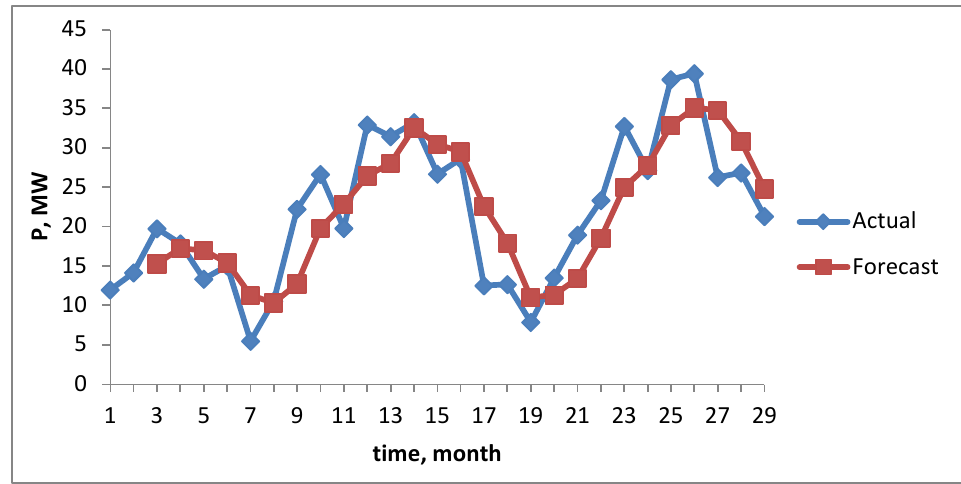
Figure 13. Charts of data between January 2014 and June 2016 with monthly average and moving average respectively.